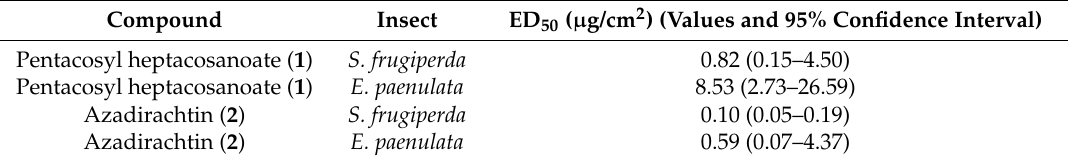
Table 1. Effective antifeedant dose 50 (ED 50 ) of 1 and 2 against Spodoptera frugiperda and Epilachna paenulata determined by choice